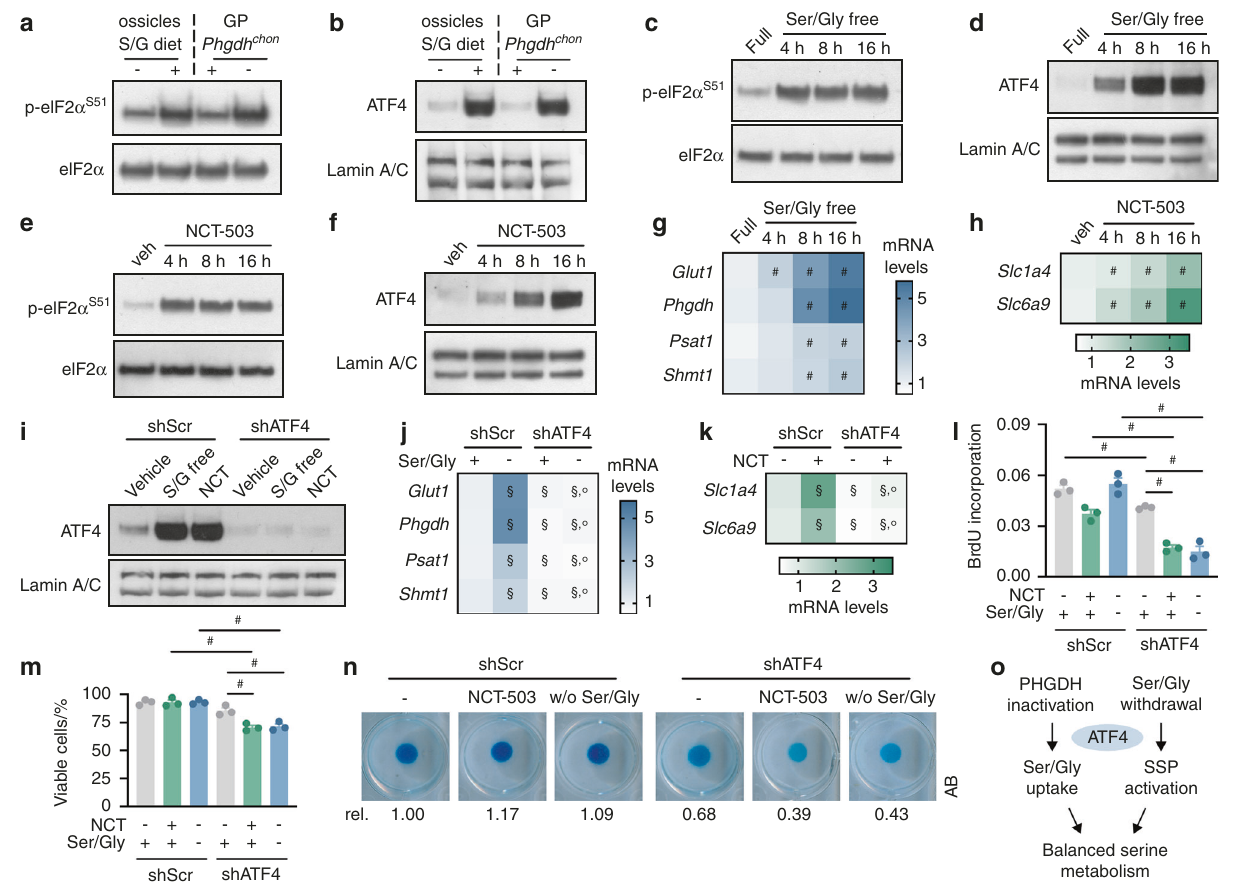
Fig. 6 ATF4 mediates the cellular response to serine metabolic challenge. Immunoblots of phosphorylated eIF2 α (Serine 51; p-eIF2 α S51 ) and eIF2 α ( a ) and of nuclear ATF4 and Lamin A/C ( b ) in bone ossicles and growth plates (GPs). For ectopic implants, chondrogenically primed wild- type progenitors were used as described in Fig. 5a and implanted in mice fed a normal chow ( − ) or serine/glycine (S/G)-free diet ( + ). Growth plates were dissected from wild-type ( Phgdh chon + ) and chondrocyte-speci fi c PHGDH knockout ( Phgdh chon − ) mice ( n = 3). Immunoblots of p- eIF2 α S51 and eIF2 α ( c ) and of nuclear ATF4 and Lamin A/C ( d ) in chondrocytes cultured in serine/glycine (Ser/Gly)-free medium for the indicated durations ( n = 3). Immunoblots of p-eIF2 α S51 and eIF2 α ( e ) and of nuclear ATF4 and Lamin A/C ( f ) in chondrocytes treated with vehicle (veh) or NCT-503 for the indicated durations ( n = 3). g Glut1 , Phgdh , Psat1 , and Shmt1 mRNA levels in chondrocytes cultured in Ser/Gly- free medium for the indicated durations ( n = 3). h Slc1a4 and Slc6a9 mRNA levels in chondrocytes treated with NCT-503 for the indicated durations ( n = 3). i Immunoblot of nuclear ATF4 and Lamin A/C in chondrocytes after transduction with a lentiviral vector carrying a shRNA against ATF4 ( n = 3). A scrambled shRNA (shScr) was used as the control. Control and ATF4-knockout cells were cultured in serine/ glycine-free medium or treated with NCT-503 (NCT). j Glut1 , Phgdh , Psat1 , and Shmt1 mRNA levels in control and ATF4-de fi cient chondrocytes cultured in complete medium ( + ) or serine/glycine-free medium ( − ) ( n = 3). k Slc1a4 and Slc6a9 mRNA levels in control and ATF4-de fi cient chondrocytes treated with or without NCT-503 ( n = 3). NCT- represents vehicle-treated. l Proliferation of control and ATF4-de fi cient chondrocytes cultured in complete or serine/glycine-free medium or treated with or without NCT-503 ( n = 3), as evidenced by BrdU